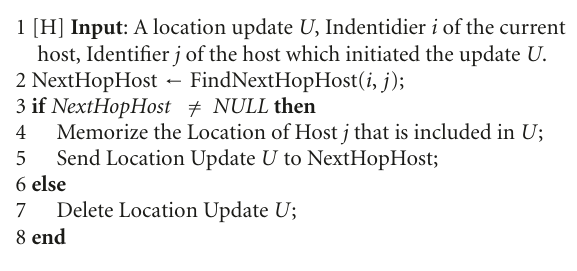
Algorithm 2: ForwardLocationUpdate.